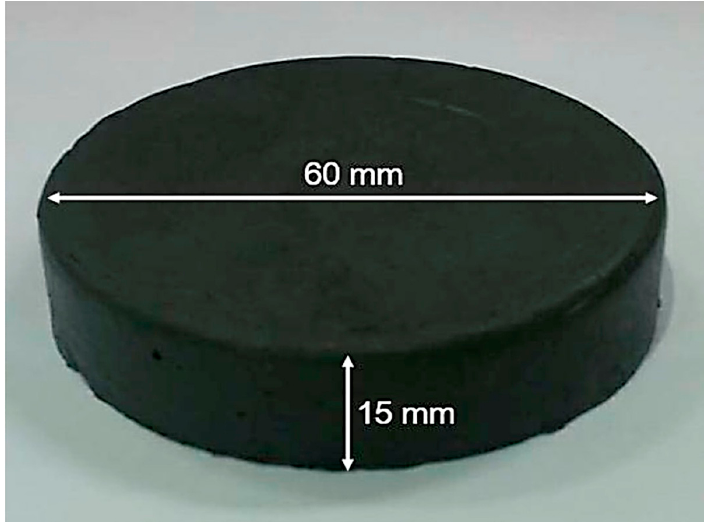
Figure 1. Fabricated isotropic magnetorheological elastomer (MRE) sample and its dimensions [34] (reprinted with permission from Elsevier TM ). (reprinted with permission from Elsevier TM